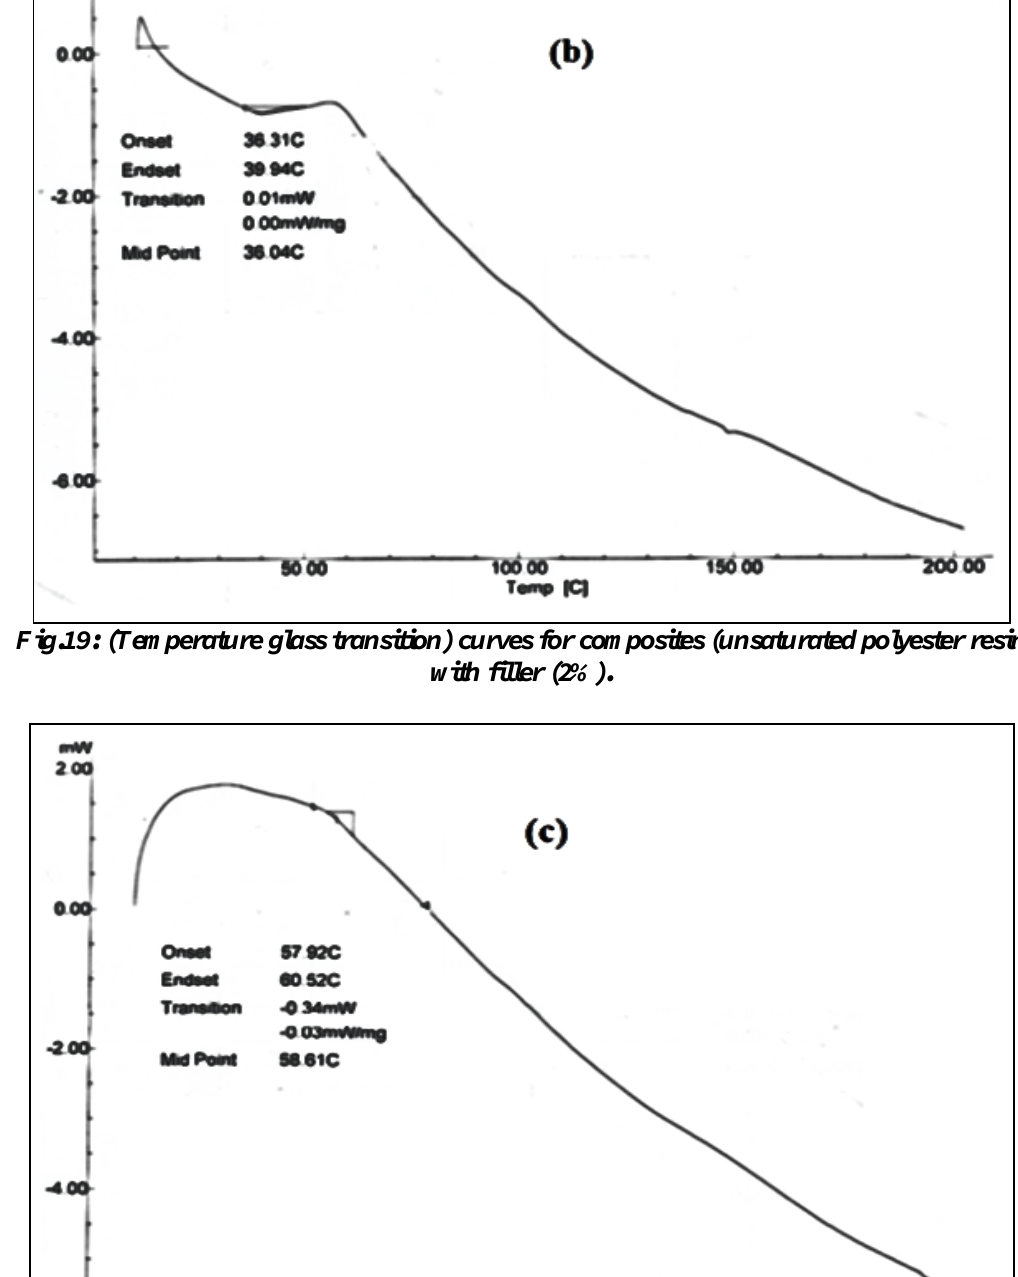
composite at X= 2